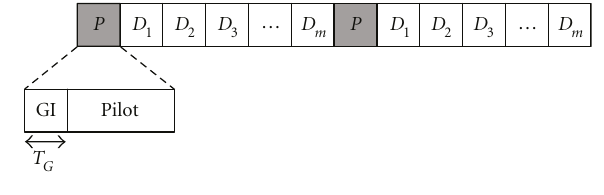
Figure 1: OFDM system frame